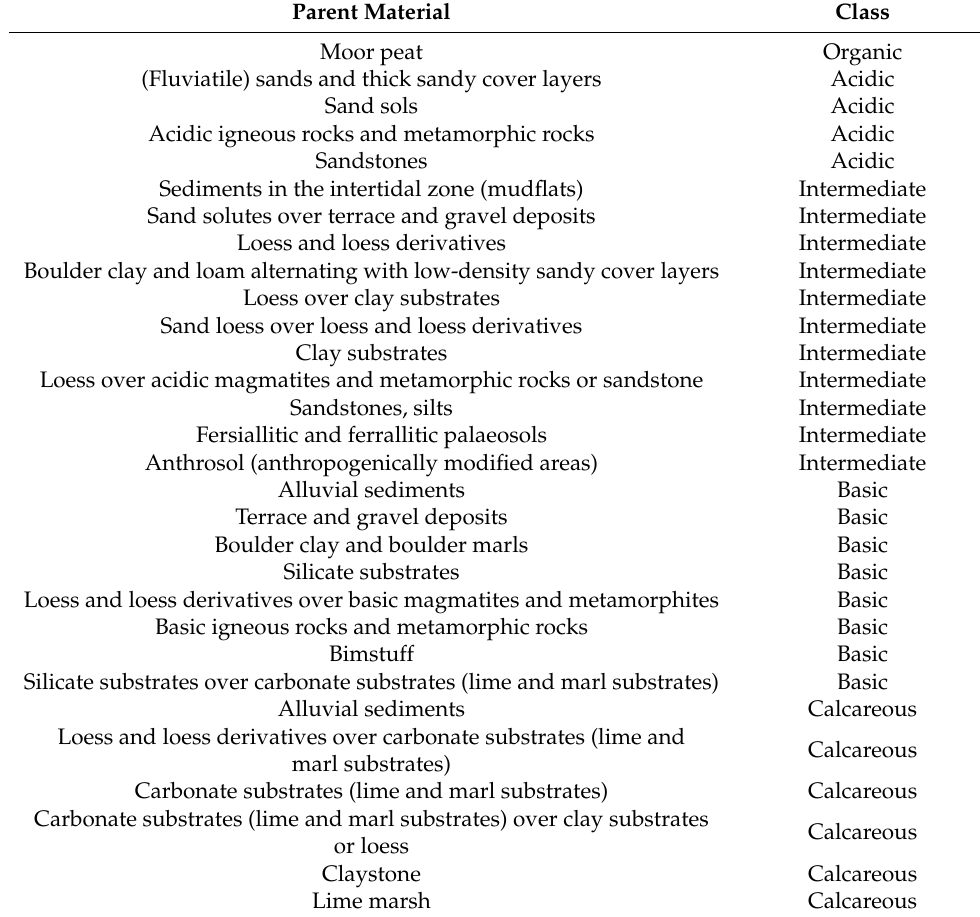
Table 18. Allocation of the initial substrates to the substrate classes (authors’ adaptation after [11,139]).